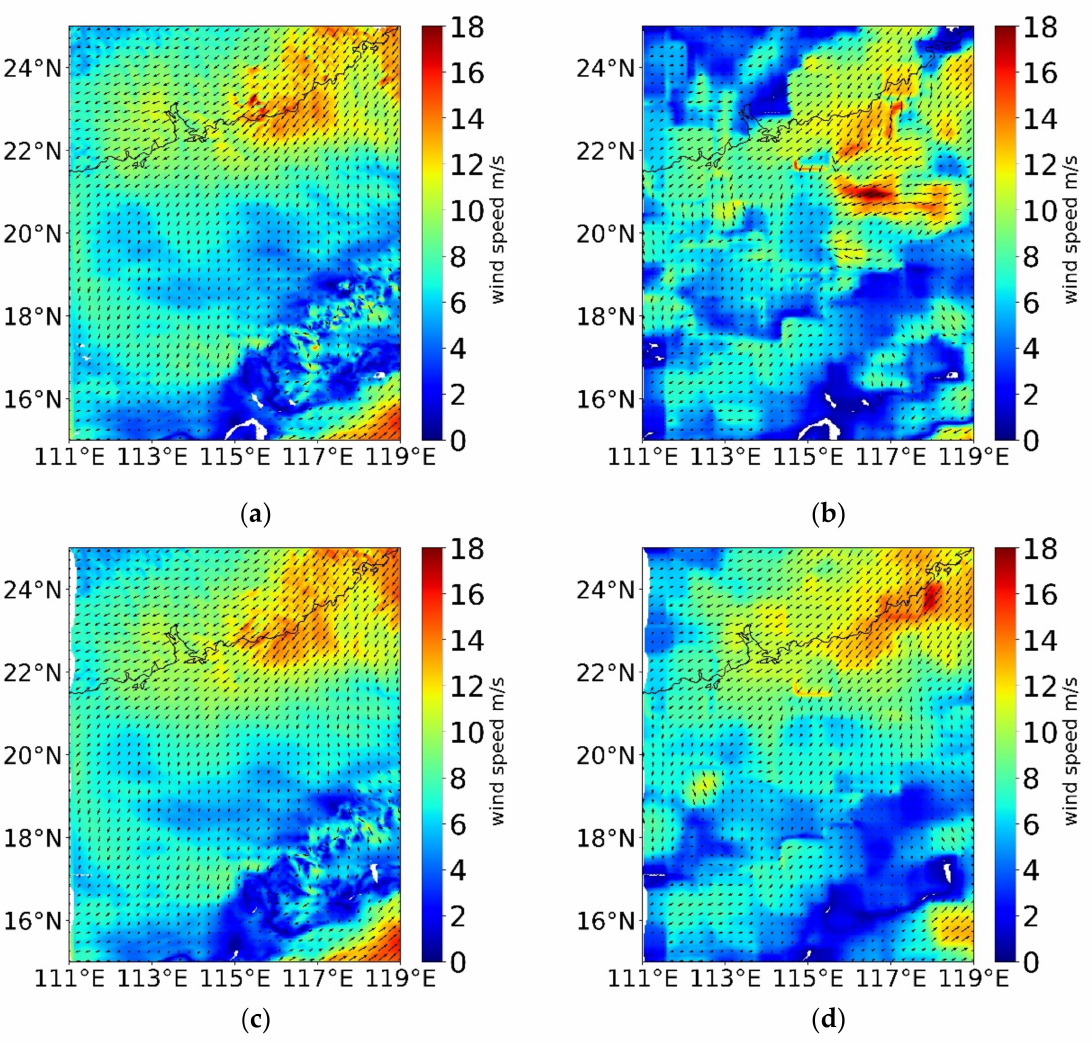
Figure 10. The WRF wind field ( a ) and OF wind field ( b ) of the selected smooth area with 5 min revisiting time at 400 hPa. The WRF wind field ( c ) and OF wind field ( d ) of the selected smooth area with 50 min revisiting time at 400